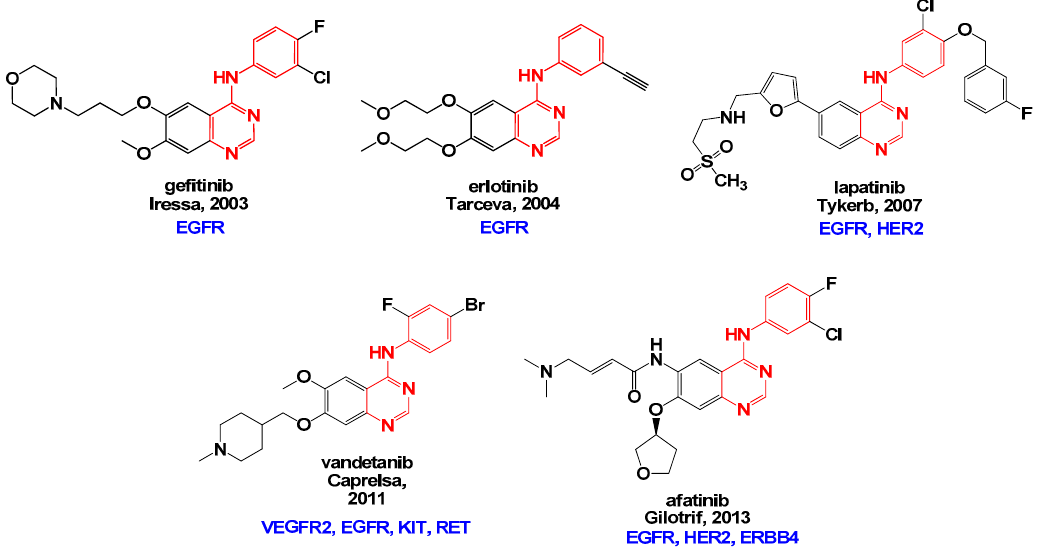
Figure 2. FDA-approved kinase inhibitors containing 4-anilinoquinazoline. The contained PAP fragments are colored red. INN, brand name, year FDA approved, and main target kinases are provided for each kinase drug. Kinase abbreviations: HER2 (ERRB2): erythroblastic leukemia viral oncogene homolog 2; RET: rearranged during transfection; ERRB4: erythroblastic leukemia viral oncogene homolog 4.